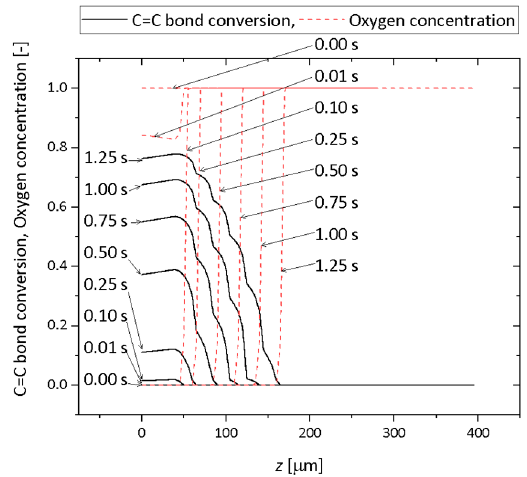
Figure 3. Contour plot of normalized oxygen concentration of 0.9 at a lift-up speed of 0.1 mm/s. The corresponding video is Video S1 on the website of the Supplementary Materials.